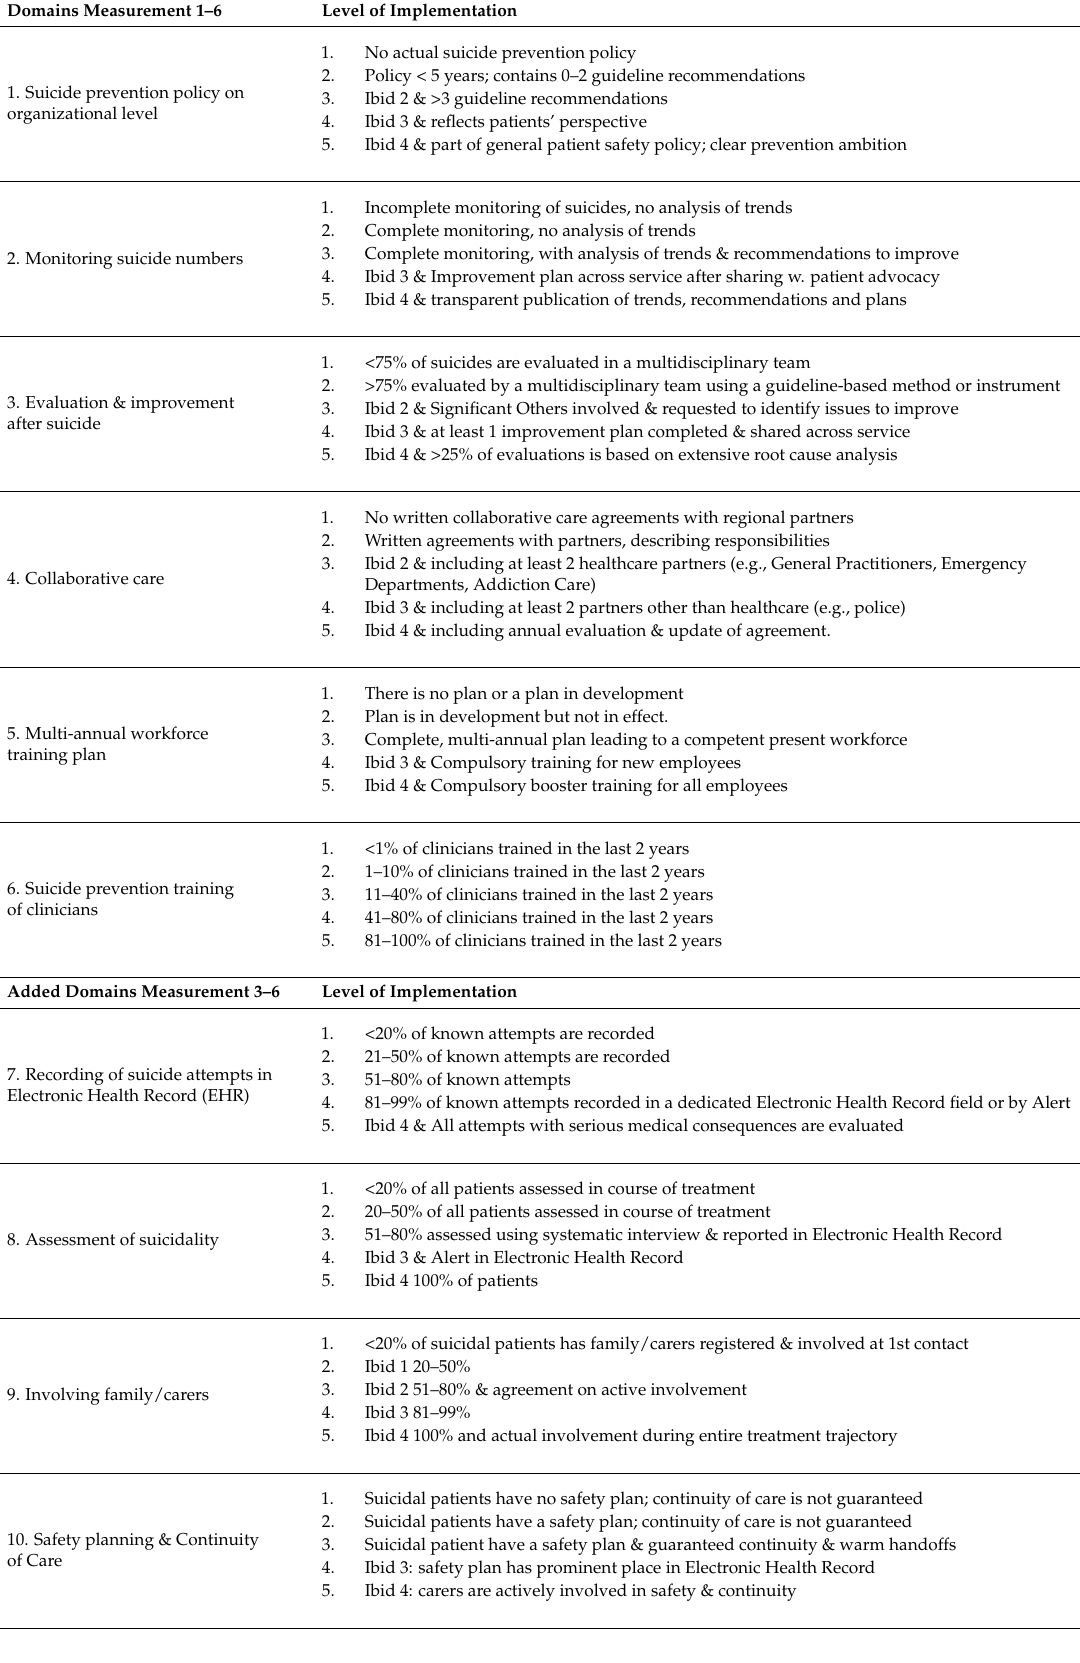
Table 1. Suicide Prevention